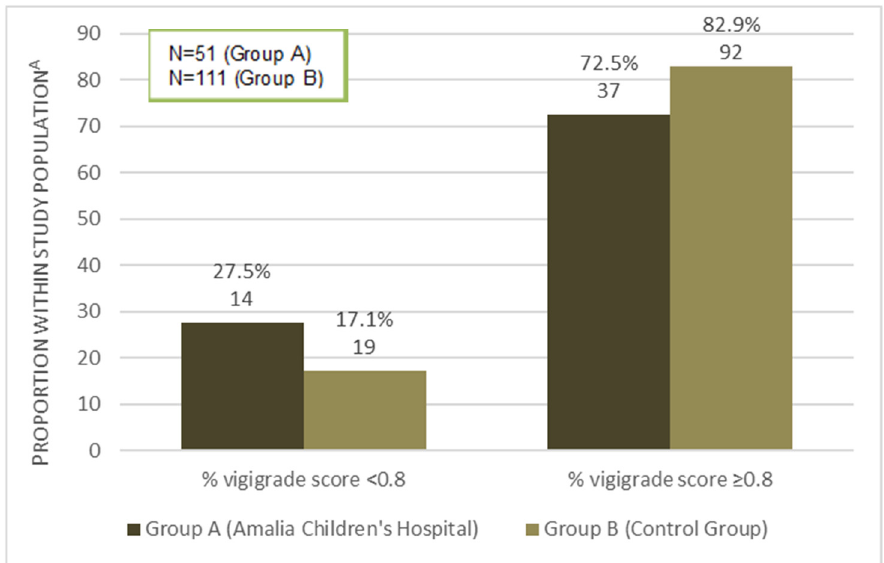
Figure 2. Results from vigiGrade: overview of reports in each category for Group A and Group B separately. Total percentage of reports within the two categories; the total absolute number of reports in the category is noted below the percentage.